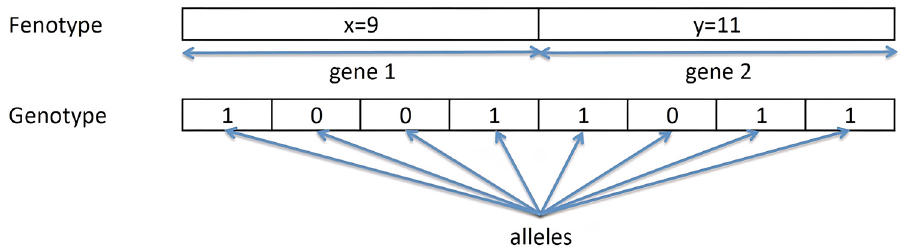
Figure 17. Example of binary coding. The coding of the solution is known as the genotype. The individual or chromosome is composed of a given number of genes. The phenotype corresponds to the solution represented by the chromosome.